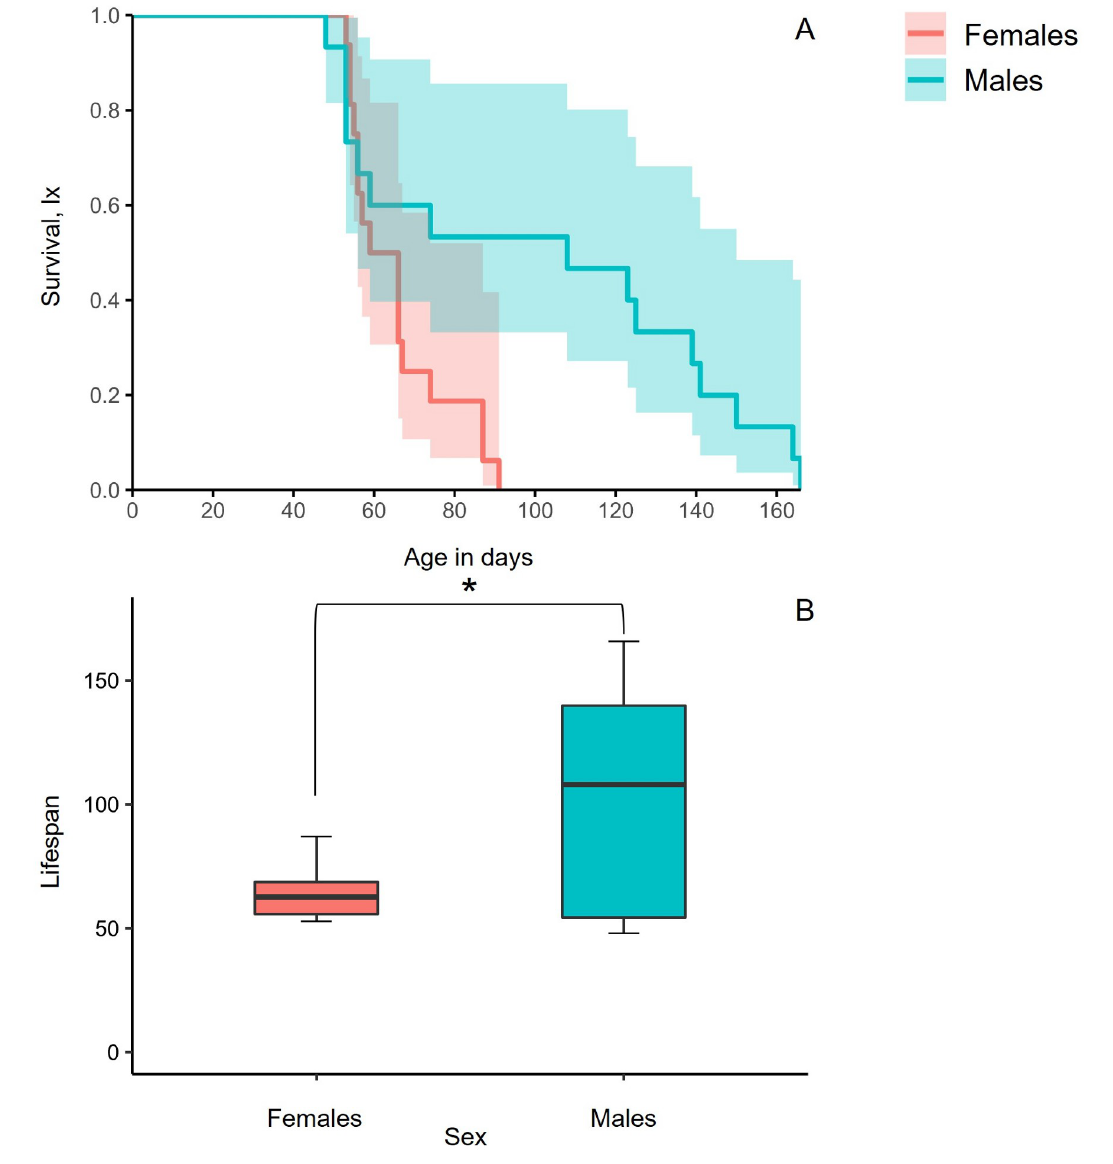
Fig 2. Age-specific survival curves with 95% Confidence Intervals (CI) (A) and box plots depicting lifespan of males and females (B) kept in the tubes of the LAM25system. motionless during darkness, regardless of the age group (Fig 6). Locomotory activity started at approximately 06:00, shortly before the start of the photophase (7:00) and stopped at approxi- mately 22:00 shortly after its end (21:00), lasting for almost 16 hours. Flies of the different age groups exhibited different patterns of locomotory activity. Therefore, we separated the 24h interval in four different periods (night, morning, midday and evening) to compare males and females (S1 Table). Male medflies exhibit a specific diurnal pattern of sexual signaling charac- terized by increased intensity in the morning and afternoon hours as it was demonstrated ear- lier [8,19,36].